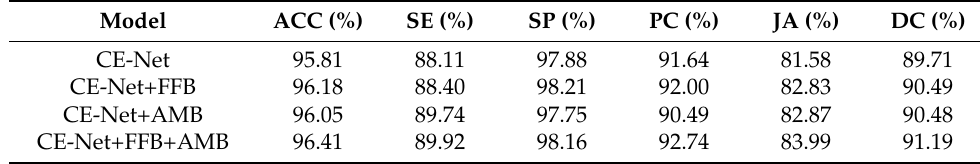
Table 2. Evaluation index of each network in ablation experiment.